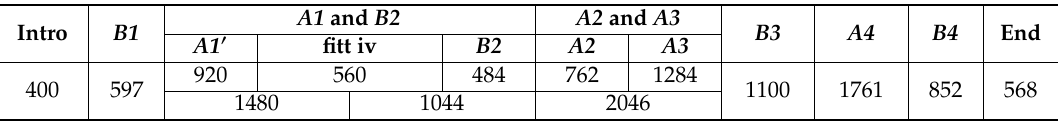
Table 5. Chunk sizes by line